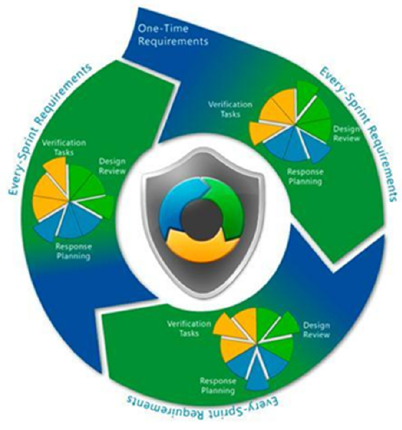
Figure 1. Agile SDL [49].